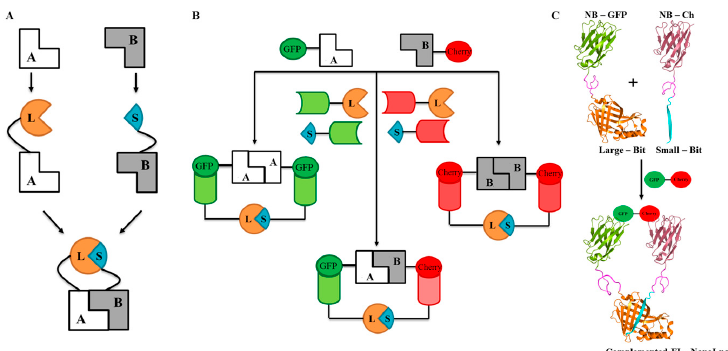
Figure 1. Schematic representations of protein complementation assays. ( A ): A generic split-luciferase assay is shown where the large bit (orange) (L—residue 1–162) and small bit (blue) (S—residue 163–174) of the split-luciferases (split-luc) (of which neither of them are active individually) are fused to interacting proteins A and B. Upon successful interaction between A and B, the L and S reconstitute resulting in luminescence [33]; ( B ): Schematic representation of a universal binary reporter system where the Large bit (L—orange) and small bit (S—blue) of the nLuc are fused with GFP-/mCherry-nanobody (light green and light red respectively) at either the N-/C-terminal. The fused proteins are separated by a flexible linker (GSSGGGGSGGGGSSG). This universal reporter system can detect either protein homodimers for GFP-tagged proteins (green) (eGFP-A:A-sGFP) and mCherry-tagged proteins (mCherry-B:B-mCherry), or heterodimers of GFP- and mCherry-tagged (red) proteins (eGFP-A:B-mCherry); ( C ): Crystal structure representation of the universal binary reporter split-luc assay of GFP-nanobody, split-luc large bit, and the small bit [33,34]. The anti-GFP nanobody (light green) is fused with large bit (orange) of nLuc and the anti-mCherry nanobody (light red) is fused with small bit (blue). This complex when mixed with GFP-mCherry heterodimer (green and red respectively), the binding of anti-GFP and anti-mCherry nanobody to their respective partners facilitates the complementation of full-length nLuc reporter.